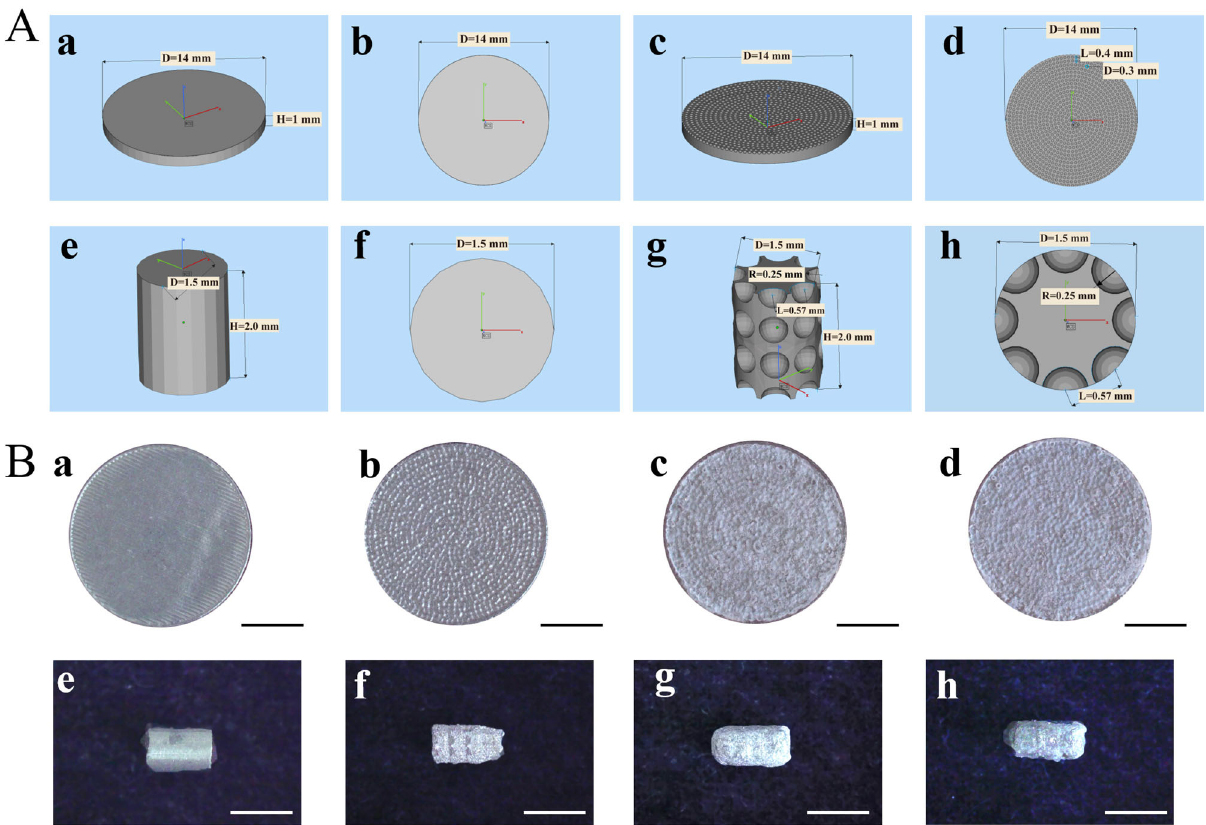
Fig. 1 Designed 3D models and fabricated entities of different samples. A 3D models of Ti64 and Ti64-M. Figure b, d, f, h are the top view of fi gure a, c, e, g, respectively. B Macro surface morphology of different samples. Scale bars indicate 5 mm (a – d) and 2 mm (e –